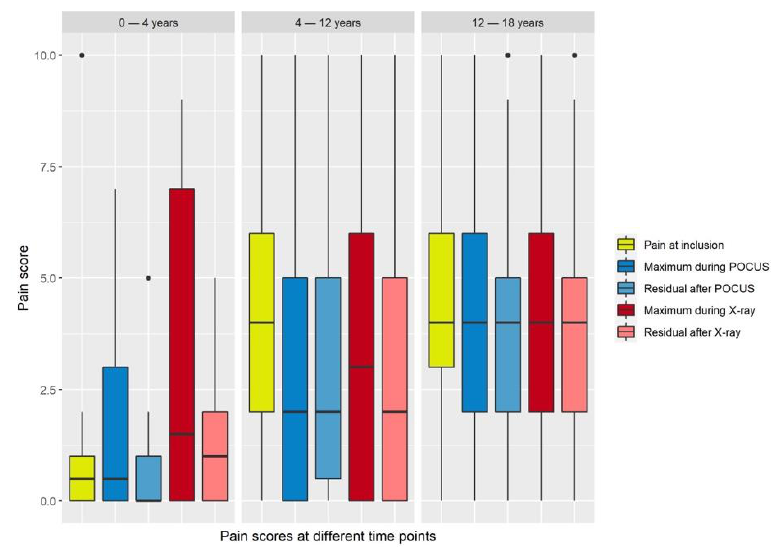
Figure 3. Box plots of pain levels by age group and rating scale: 0 – 4 years: KUSS; 4 – 12 years: VAS; 12 – 18 years: NRS.